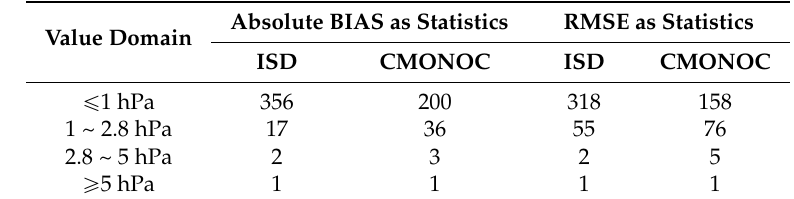
Table 1. Number of sites at which absolute BIAS or RMSE of interpolated surface pressure were within a given special value domain.